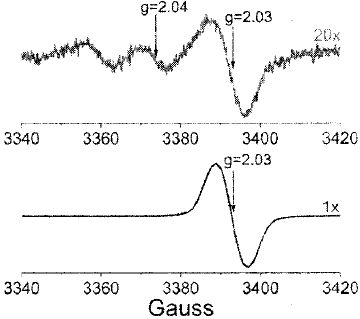
Figure 9. EPR signals of MNICs and DNICs with cysteine respectively at g = 2.04 or 2.03 detected in 140 ms (on the top, a mixture of these signals is registered) and in five seconds (at the bottom, only the EPR signal of DNICs with cysteine is registered) after mixing Fe 2+ (0.09 mM) with NO (0.93 mM) and cysteine (10 mM). The signals were recorded at room temperature. On the right, spectroradiometer amplification is shown in relative units [33].